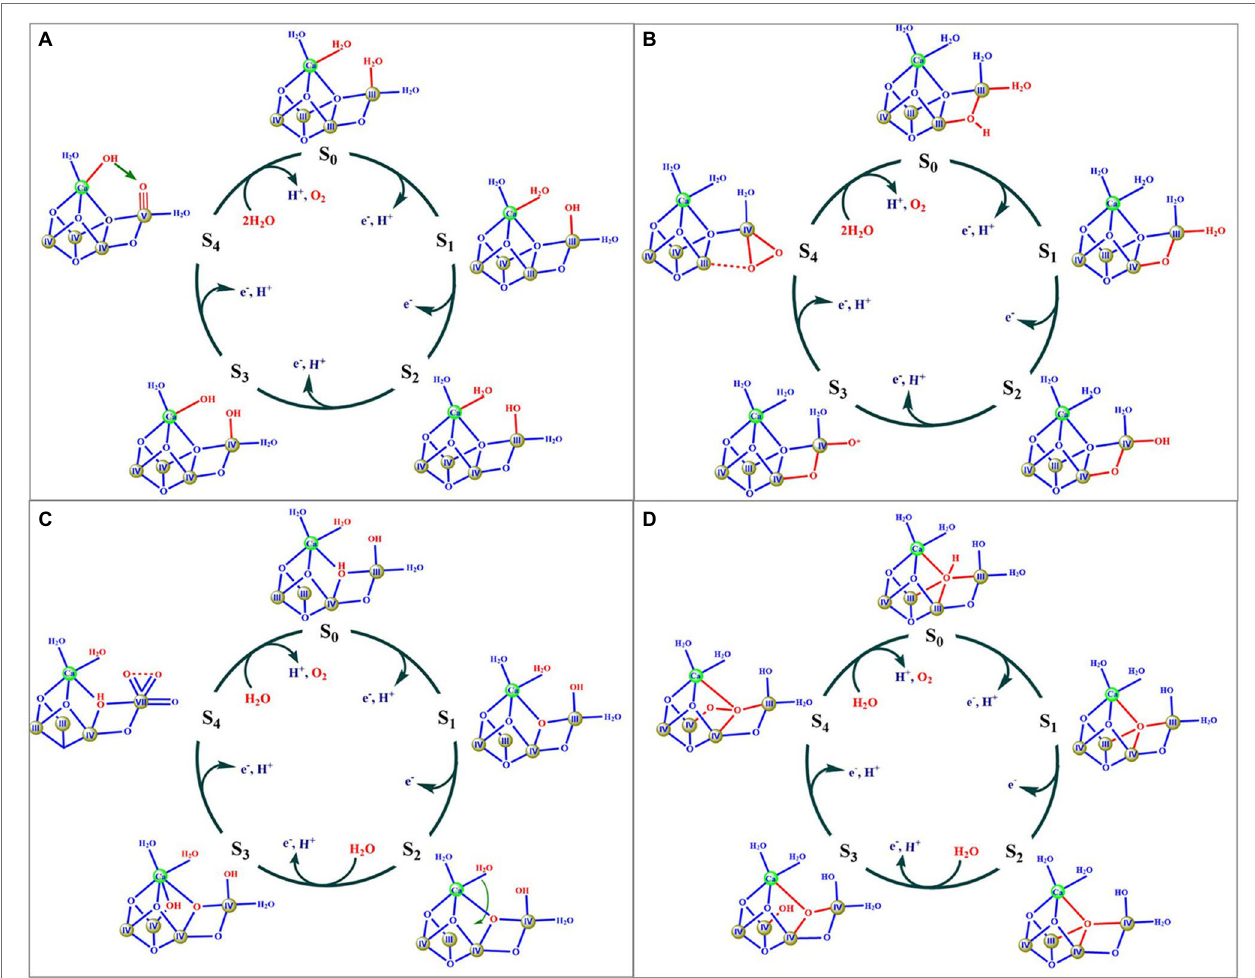
FIGURE 3 | Four typical mechanism models suggested in literatures. Components of the OEC involved in O=O bond formation are marked by red color. Roman numbers indicate the oxidation state of the Mn